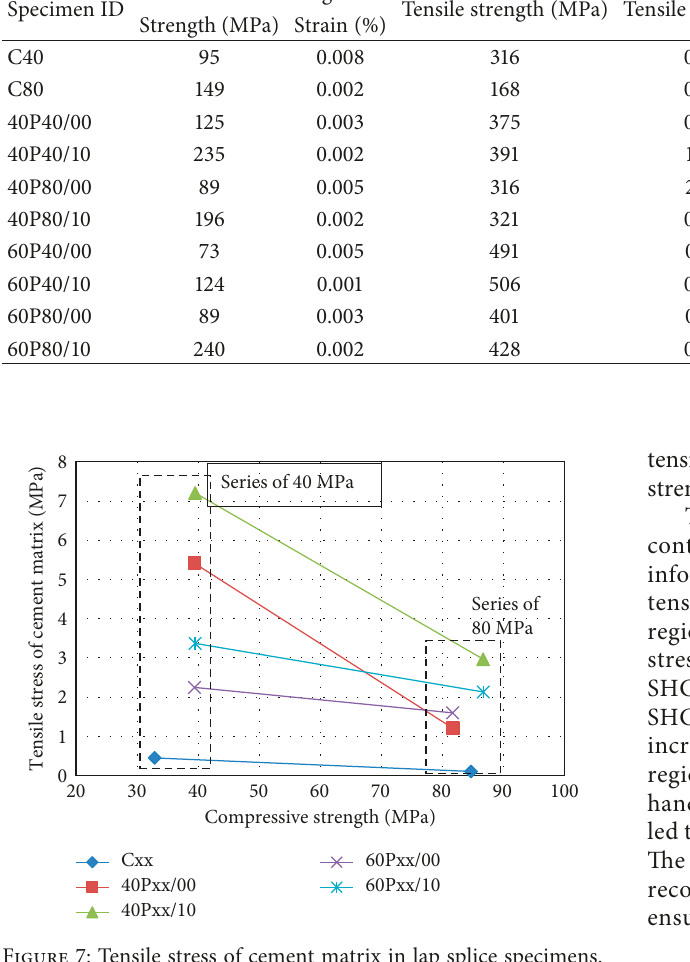
Figure 7: Tensile stress of cement matrix in lap splice specimens.